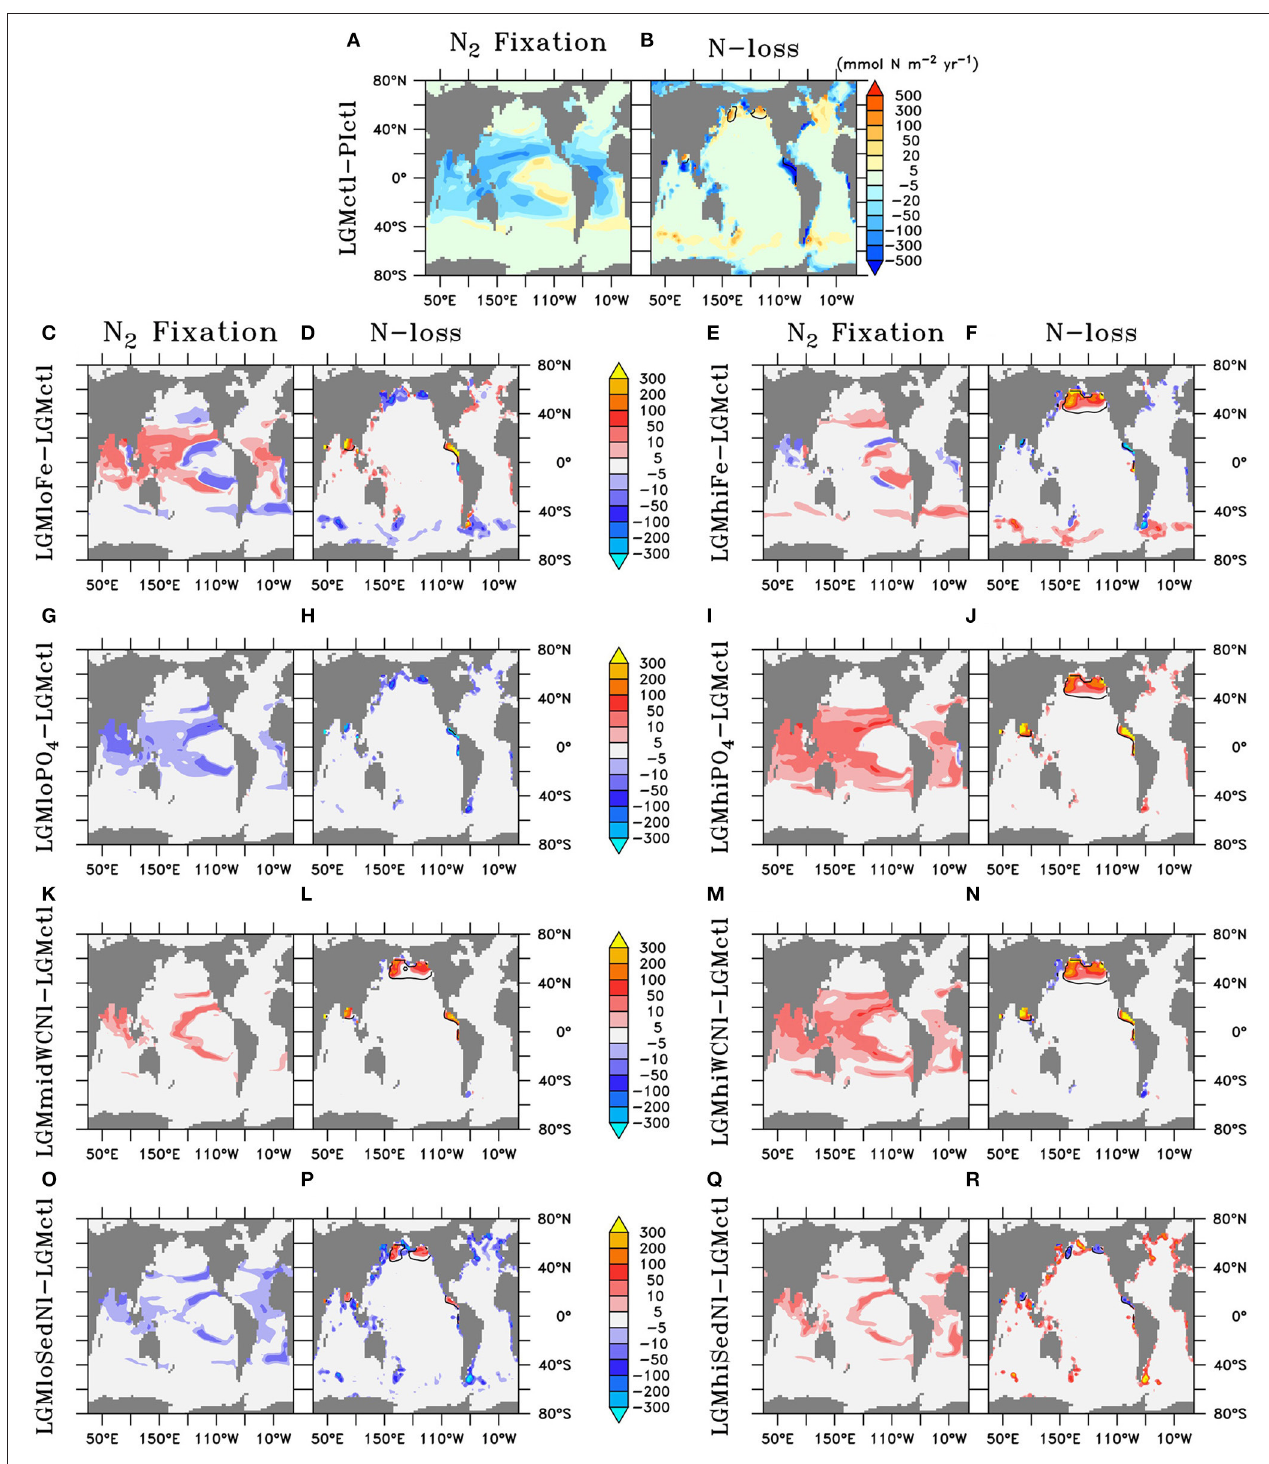
FIGURE 5 | Vertically-integrated differences of N 2 fixation and total N-loss, respectively, of (A,B) Last Glacial Maximum control (LGMctl) minus preindustrial control (PIctl) and the Last Glacial Maximum simulations minus LGM control: (C,D) LGMloFe, (E,F) LGMhiFe, (G,H) LGMloPO 3 − 4 , (I,J) LGMhiPO 3 − 4 , (K,L) LGMmidWCNl, (M,N) LGMhiWCNl, (O,P) LGMloSedNl, and (Q,R) LGMhiSedNl. Contours of minimum dissolved oxygen (10 mmol m − 3 ) in the water column show where water column N-loss occurs.